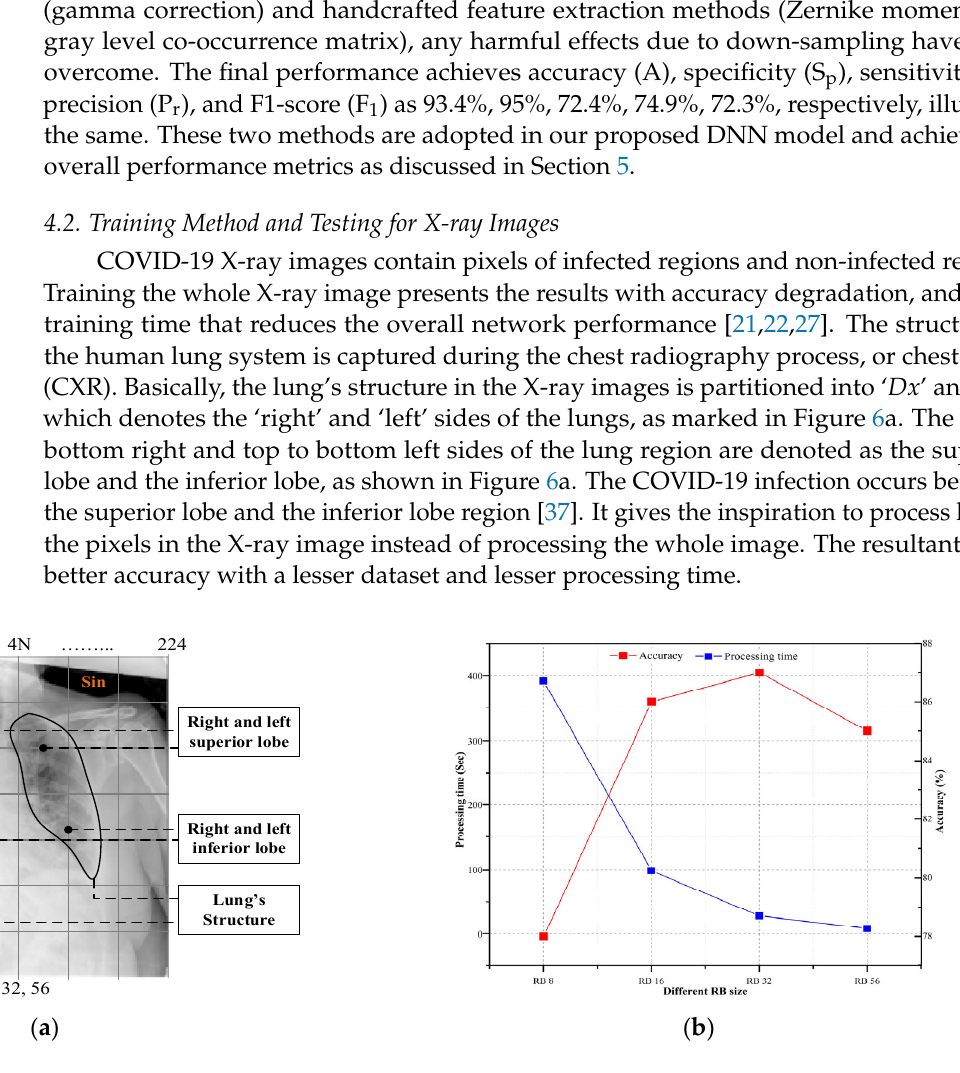
Figure 6. ( a ) Visual representation of X-ray image with different RB sizes, ( b ) RB size versus processing time and accuracy.